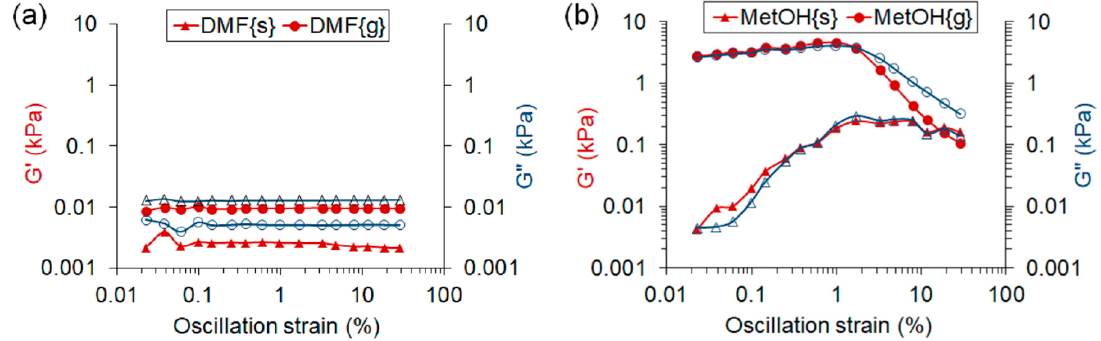
Figure A1. Rheological properties of PHEMA solutions and gels. Storage (G’, red) and loss modulus (G”, blue) of PHEMA solutions {s} and “re-swelled” gels {g} in DMF ( a ) or MetOH ( b ).